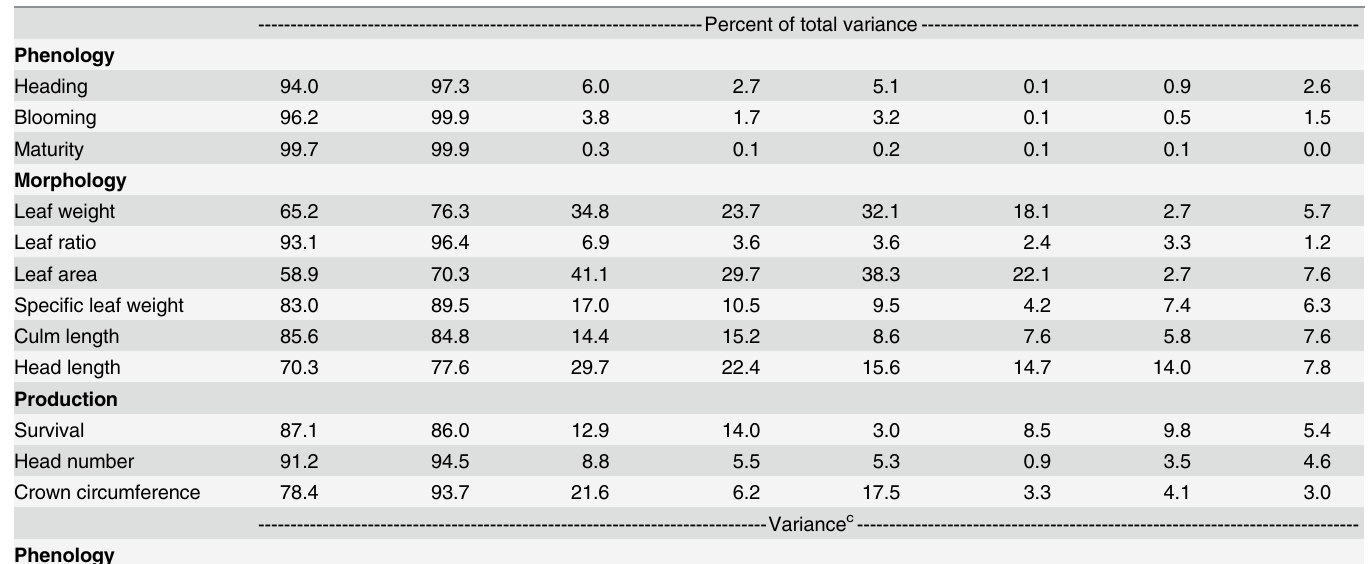
Genetic families within populations